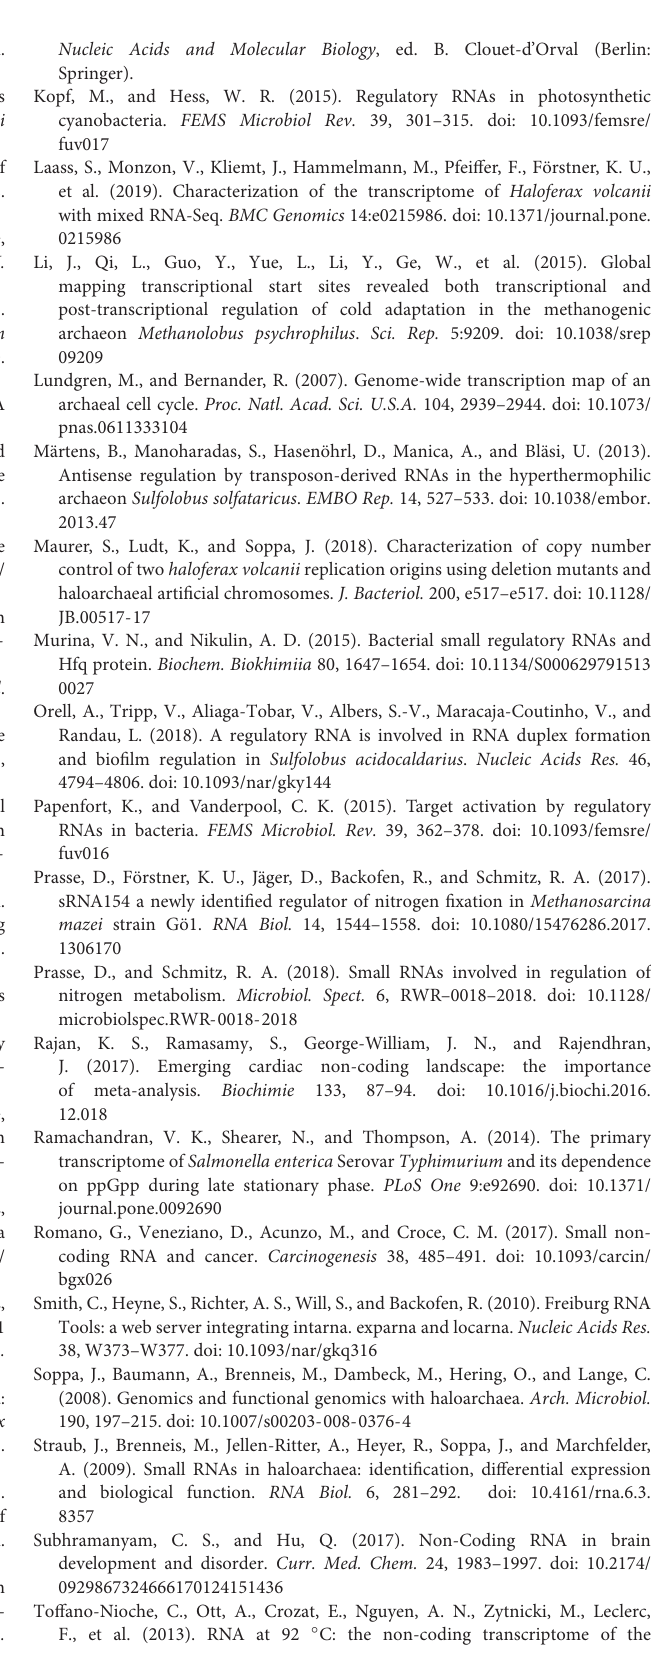
Frontiers in Microbiology |